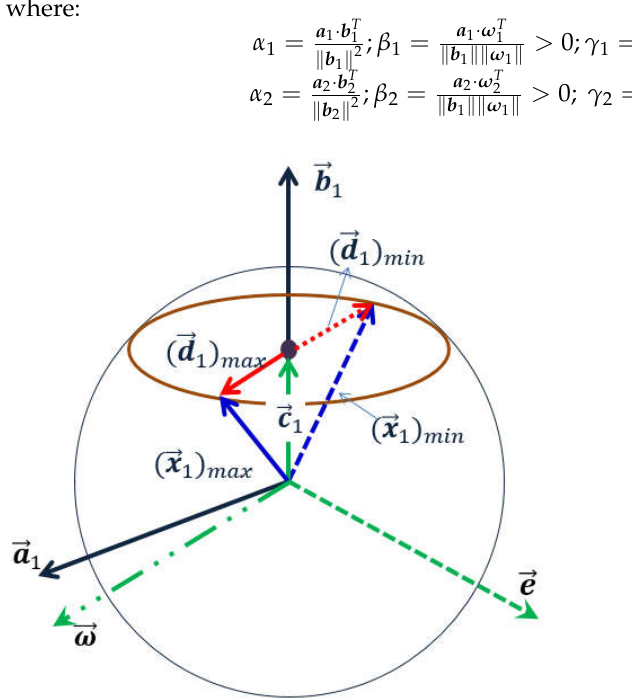
Figure 6. The diagram of vector conversion relation of the optimal Equation (9).